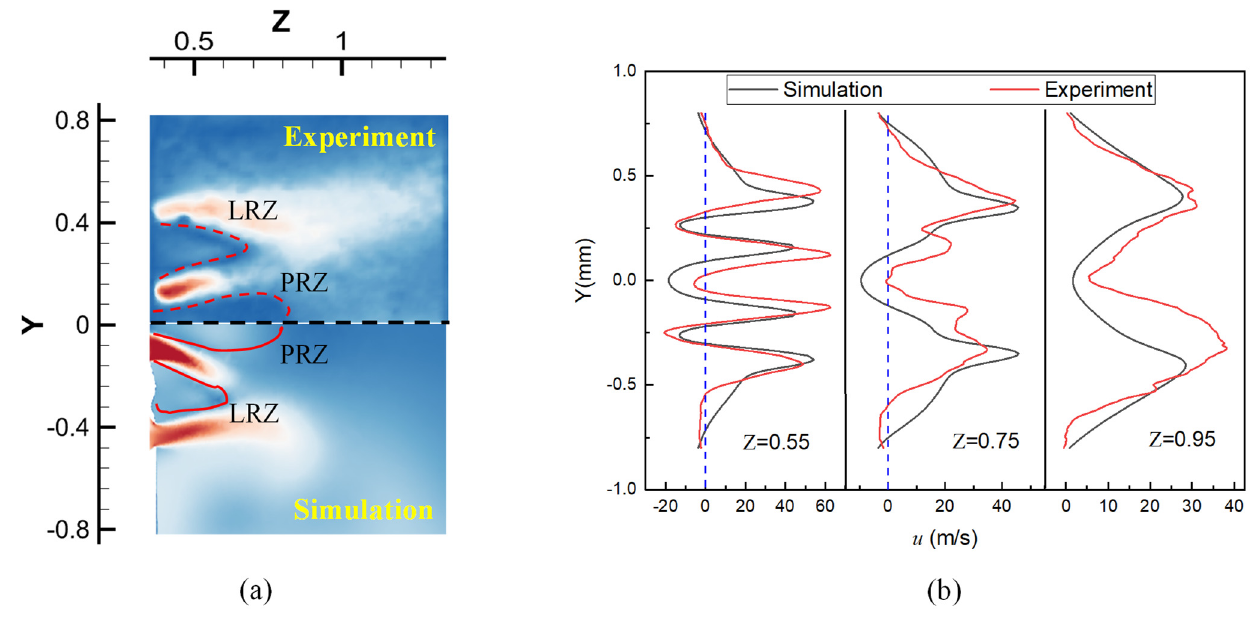
Figure 6. The flow characteristics on both experiment and simulation for validation. ( a ) the average flow field. ( b ) the axial velocity distributions. Table 2. R² of axial velocity.